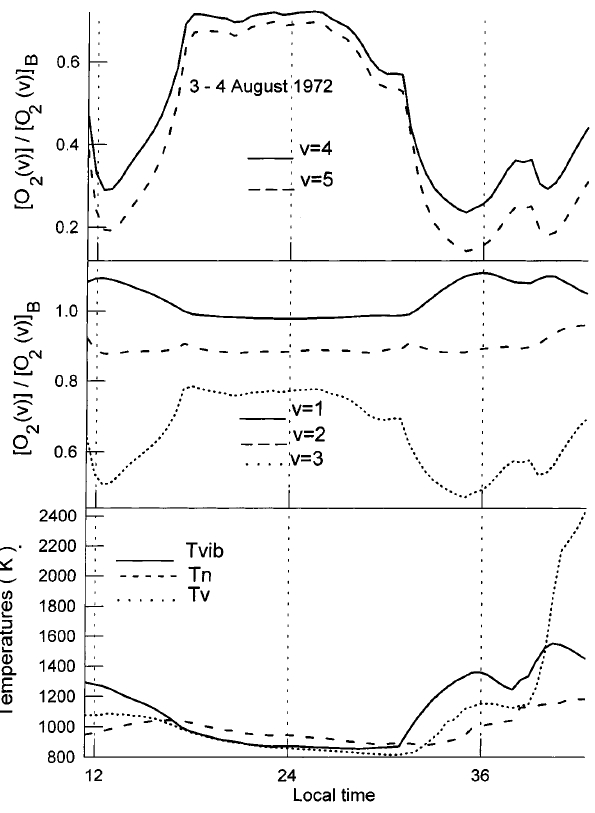
Fig. 4. The time variations of the vibrational temperatures of (cid:137) O 2 (cid:138) and (cid:137) N 2 (cid:138) , the neutral temperature ( bottom panel ), and populations of the first five vibrational levels of O 2 (cid:133) v (cid:136) 1 ; 2 ; and 3 in the middle panel and v (cid:136) 4 and 5 in the top panel ) in comparison with the Boltzmann distribution of Eq. (25) during the 3–4 August period at the F2 peak altitude. The solid lines show the modelled T vib , (cid:137) O 2 (cid:133) 1 (cid:134)(cid:138) = (cid:137) O 2 (cid:133) 1 (cid:134)(cid:138) , and (cid:137) O 2 (cid:133) 4 (cid:134)(cid:138) = (cid:137) O 2 (cid:133) 4 (cid:134)(cid:138) , the dashed lines show the B B modelled T n ; (cid:137) O 2 (cid:133) 2 (cid:134)(cid:138) = (cid:137) O 2 (cid:133) 2 (cid:134)(cid:138) , and (cid:137) O 2 (cid:133) 5 (cid:134)(cid:138) = (cid:137) O 2 (cid:133) 5 (cid:134)(cid:138) , and the dotted B B lines show the modelled T v , and (cid:137) O 2 (cid:133) 3 (cid:134)(cid:138) = (cid:137) O 2 (cid:133) 3 (cid:134)(cid:138)